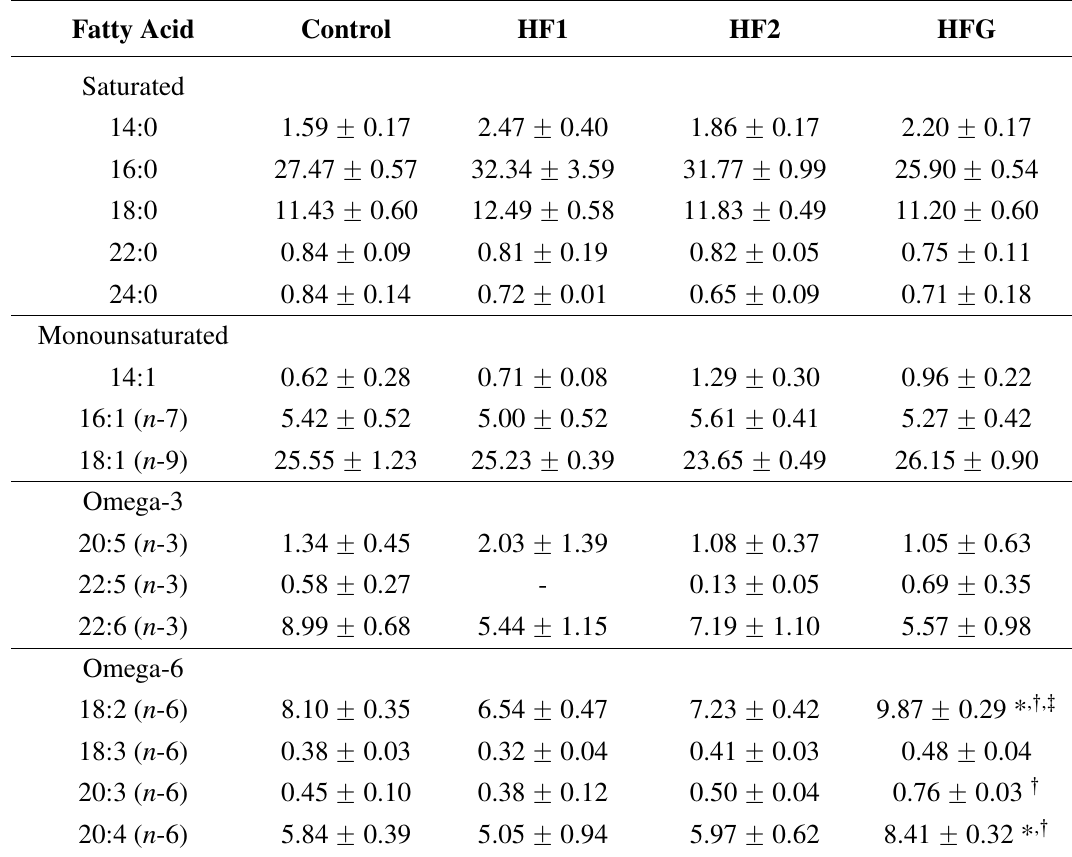
Table 2. Plasma fatty acid profiles (%) of 20-day-old rat fetuses maintained on a high fat diet. Fatty Acid Control HF1 HF2 HFG Saturated